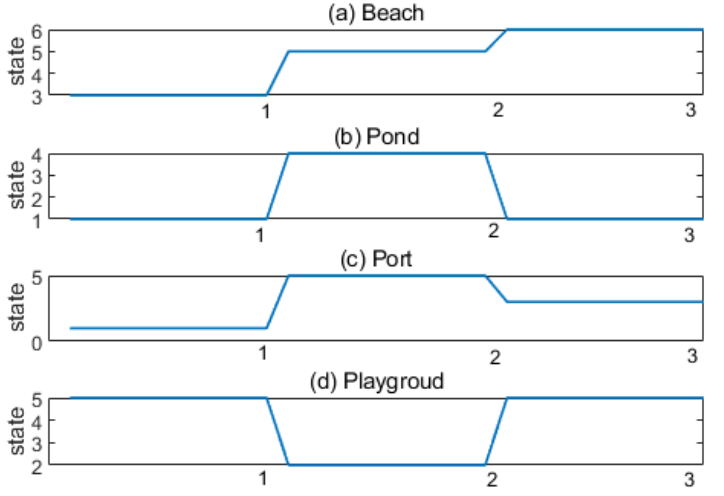
Figure 6. The “hidden state evolution laws” obtained by the HMM according to several different remote sensing images shown in Figure